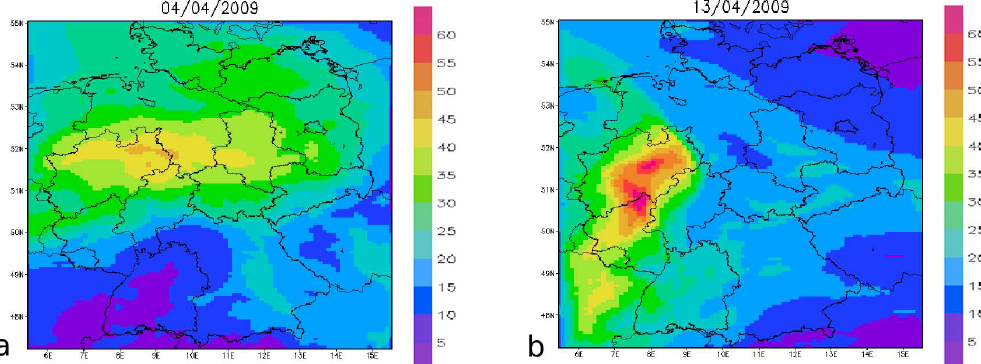
Fig. 8. Modelled mean SIA concentration of the base run for (a) 4 April 2009 and (b) 13 April